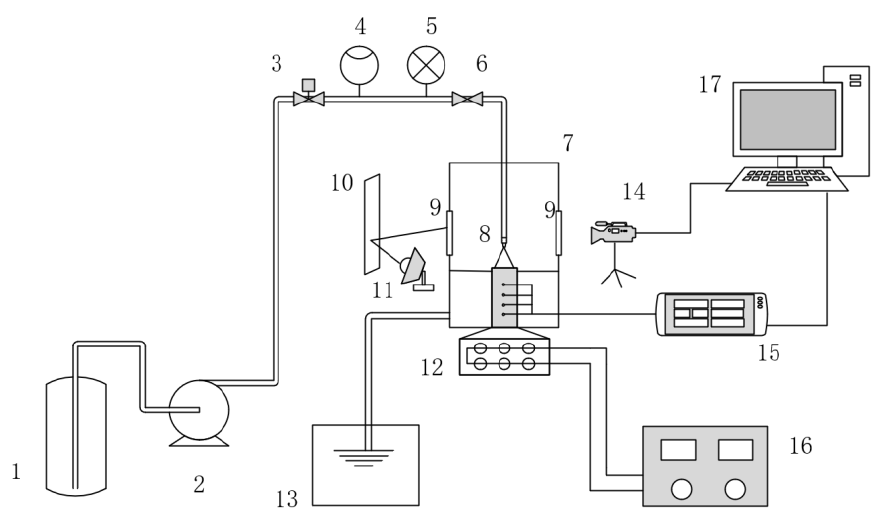
Figure 1. Schematic diagram of spray system. 1 liquid storage tank; 2 micro high-pressure pump; 3 flow adjustment valve; 4 flow meter; 5 pressure gauge; 6 stop valve; 7 spray chamber; 8 nozzle; 9 observation window; 10 reflector; 11 fill light; 12 heating rod; 13 waste liquid collection tank; 14 high-speed camera; 15 data acquisition instrument; 16 heating power regulator; 17 computer.